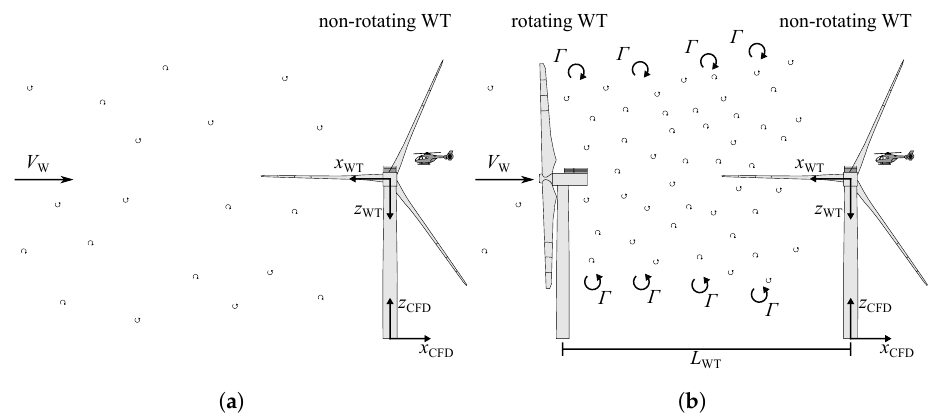
Figure 3. Operational Scenario 2 (OS-2): Hover flight at a non-rotating WT in “L-position”. ( a ) Subcase 1: Hover flight at an isolated WT. ( b ) Subcase 2: Hover flight at a non-isolated WT ( L WT = 680m). Two potentially critical wind speeds V W based on the OFFWINDTECH WT were chosen for OS-1 and OS-2. The OFFWINDTECH WT is a slightly modified version of the NREL 5 MW generic research WT [22] and resembles the real existing WTs in the offshore wind farm GTI. The first wind speed V W corresponds to the expected strong blade tip vortices. WTs reach the maximum initial blade tip vortex circulation Γ 0 in the region of the rated wind speed V W, Ω max [8], which is reached at a medium wind speed of V W = 11.3 m/s for the considered WT. The other potentially critical wind speed was chosen as V W = 25.0 m/s to represent extreme weather conditions. As helicopter hoist operations are performed until wind speeds V W between 18–21 m/s due to limitations of the wind farm operators, the cut- off wind speed of the considered WT of V W,max = 25.0 m/s was chosen as a conservative approach. Figure 4 shows the relative frequency of the wind speed V W at the German Bight. As indicated, the chosen wind speeds V W represent a common medium wind speed and a very high wind speed.